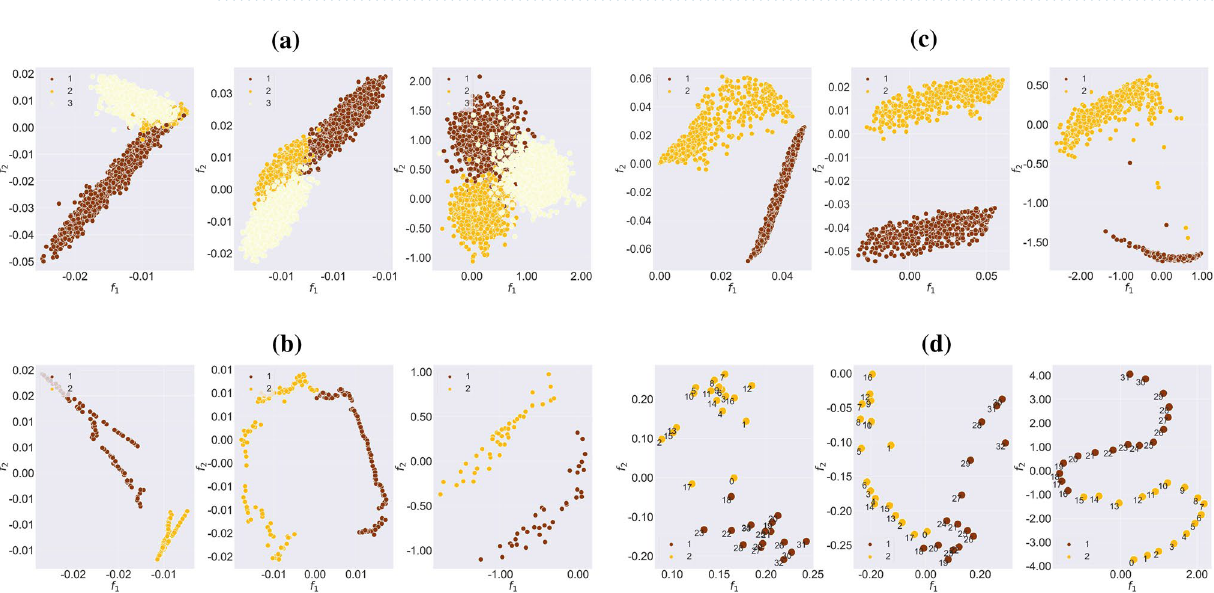
Figure 4. The evolution of the graph embedding of the time-evolving graph G during the training of our model on ( a ) CholeraInf and ( b ) MovingPic. The points are coloured according to ground-truth labels.